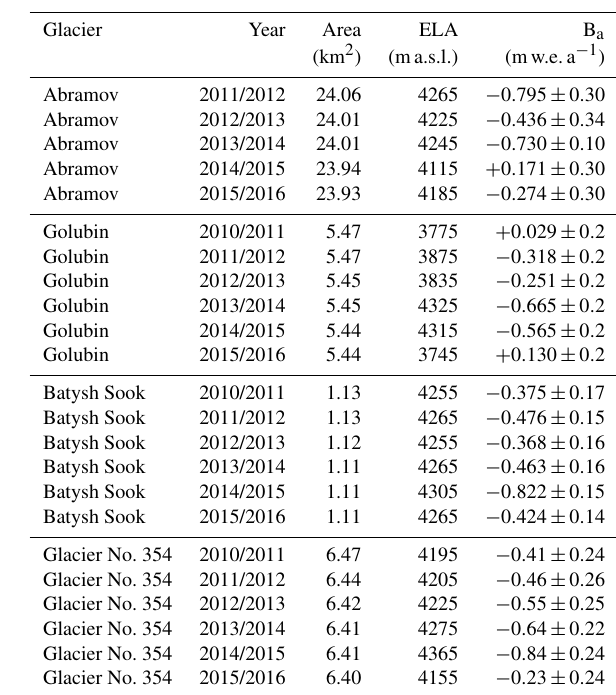
Figure 3. (a) Abramov research station in the year 1993 (photo: NSIDC); (b) ruins of the Abramov research station in 2011 (photo: M. Hoelzle).